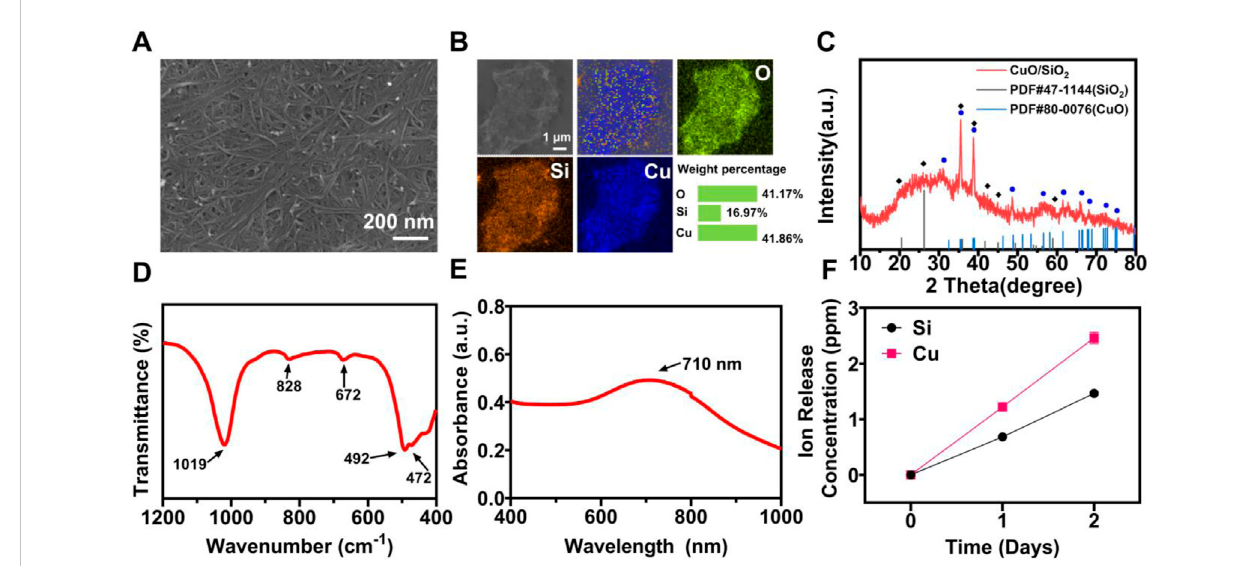
FIGURE 2 Characterization of CuSi NWs. (A) SEM image. (B) EDS mapping. (C) XRD pattern. (D) FTIR spectra. (E) UV-VIS-NIR spectrograms. (F) Accumulated release of Si and Cu ions from CuSi NWs at different